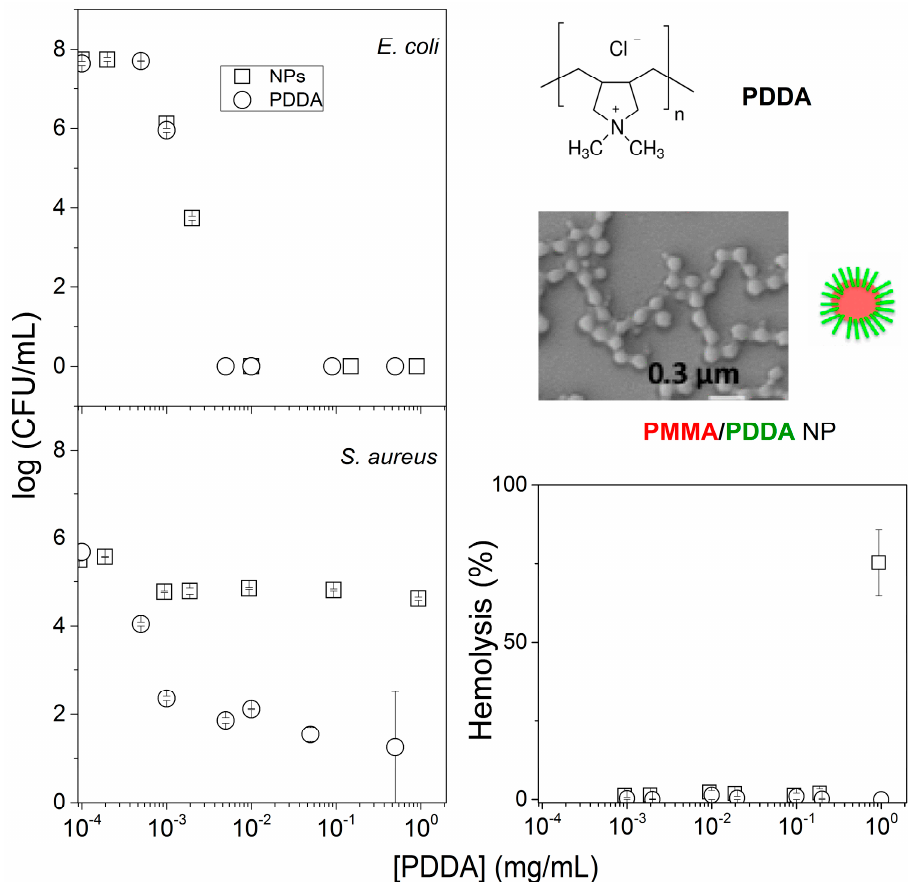
Figure 6. The compared bioactivity of a cationic antimicrobial polymer (PDDA) by itself and as the outer layer of PMMA/PDDA nanoparticles (NPs). On the left, colony forming unities (CFU) counting as a function of PDDA concentration against Escherichia coli and Staphylococcus aureus. On the right, PDDA chemical structure, scanning electron micrograph of PMMA/PDDA NPs and hemolytic activity of PDDA and PMMA/PDDA NPs as a function of PDDA concentration. Reproduced from [109].